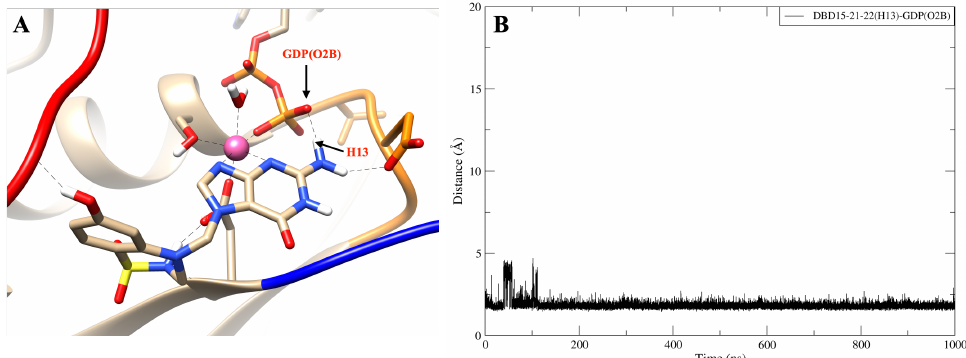
Figure A14. The hydrogen bond interaction between DBD15-21-22 (H13) and GDP (O2B). ( A ) Repre- sentative snapshot of HB DBD 15 − 21 − 22 ( H 13 ) − GDP ( O 2 B ) ; ( B ) distance between DBD15-21-22 (H13) and GDP (O2B).